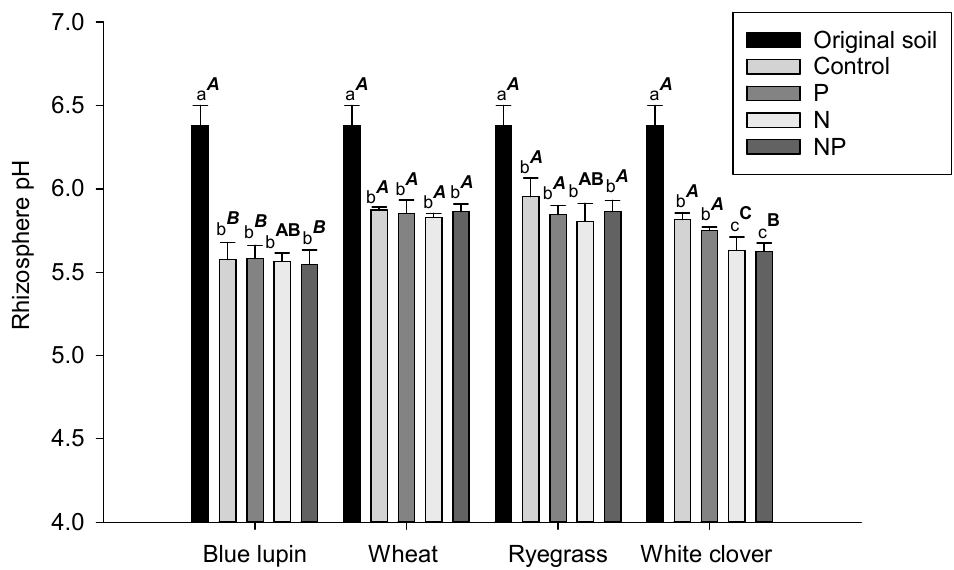
Figure 1. Rhizosphere pH values for blue lupin, wheat, ryegrass, and white clover for the control (0N, 0P), P (0N, 50P), N (300N, 0P), and NP (300N, 50P) treatments compared to the pH of the original soil. Different letters represent a significant difference ( p < 0.05) among nutrient treatments for the same plant. Different superscript letters represent a significant difference ( p < 0.05) among plant species for the same nutrient treatment.